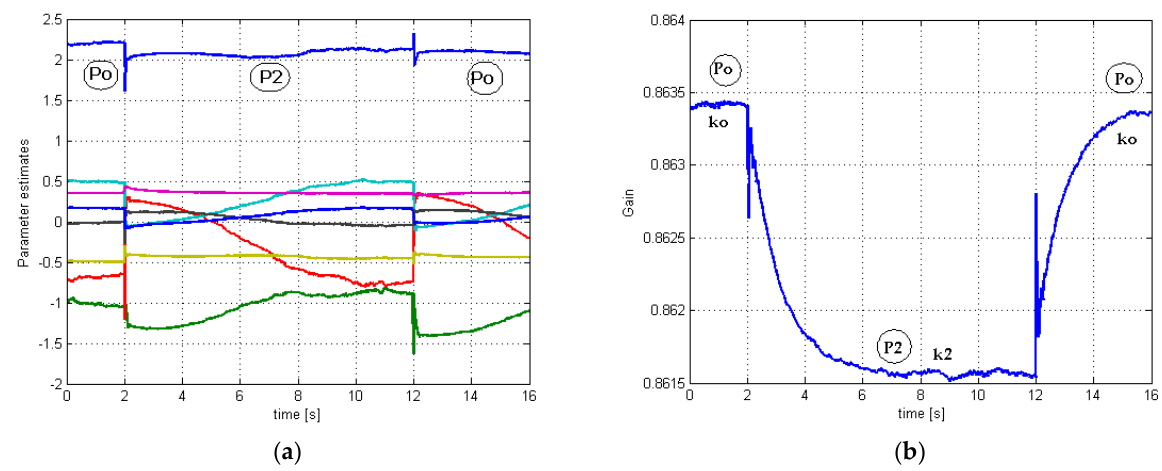
(cid:0) (cid:1) (cid:0) (cid:1) z − 1 z − 1 and B (functioning points: P 0 -> P 2 -> P o );